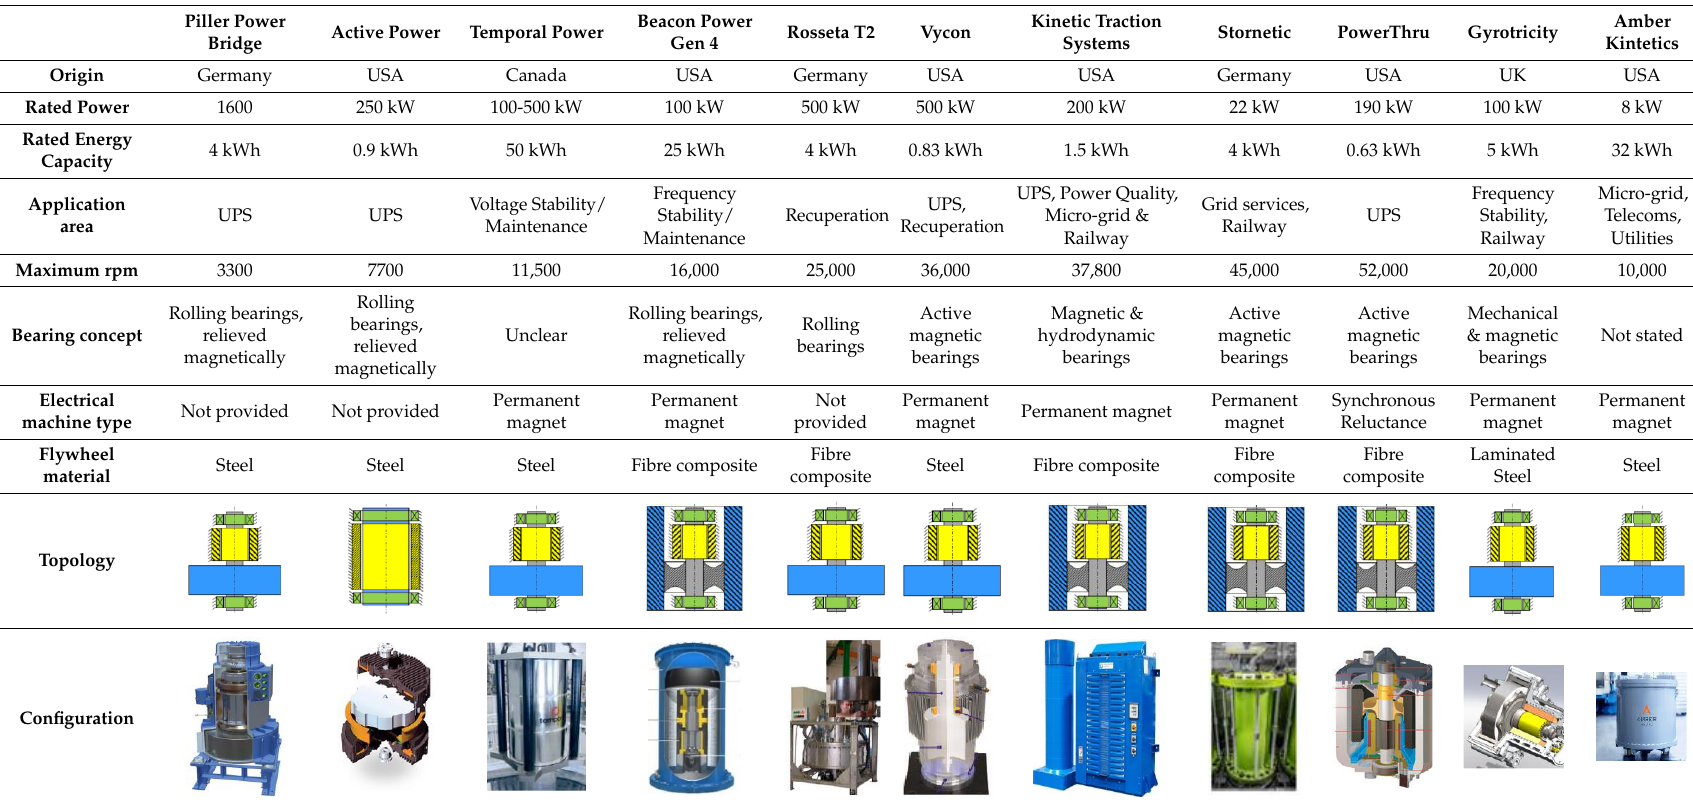
Table 2. Comparison of the characteristic properties of different commercial flywheel systems adopted from [59] and manufacturers’ websites.